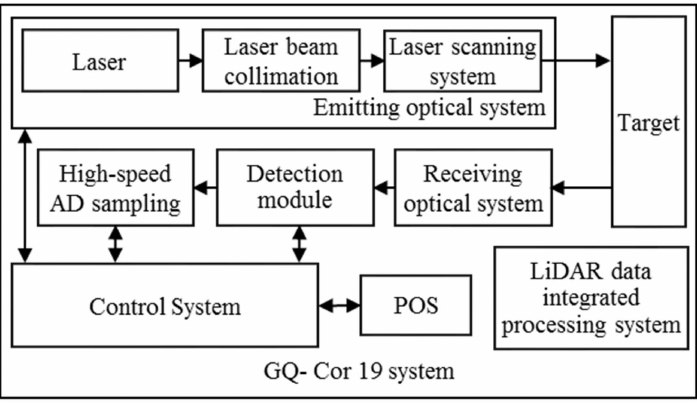
Figure 1. Architecture of GQ-Cor